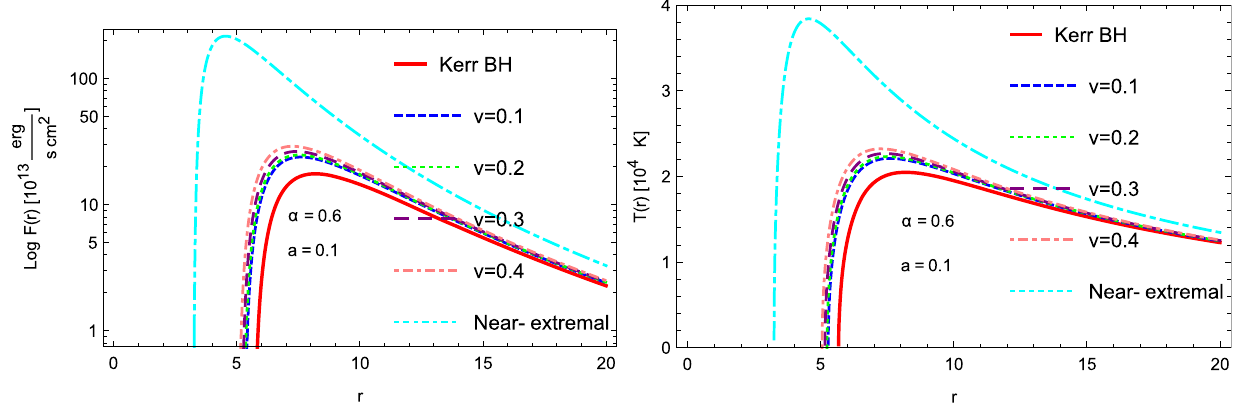
√ 1 + α 2 , the energy flux and disk the near-extremal limit, Q max ∼ M temperature have the largest maxima. The dilaton parameter is set to α = 0 . 6 and rotation parameter to a = 0 .